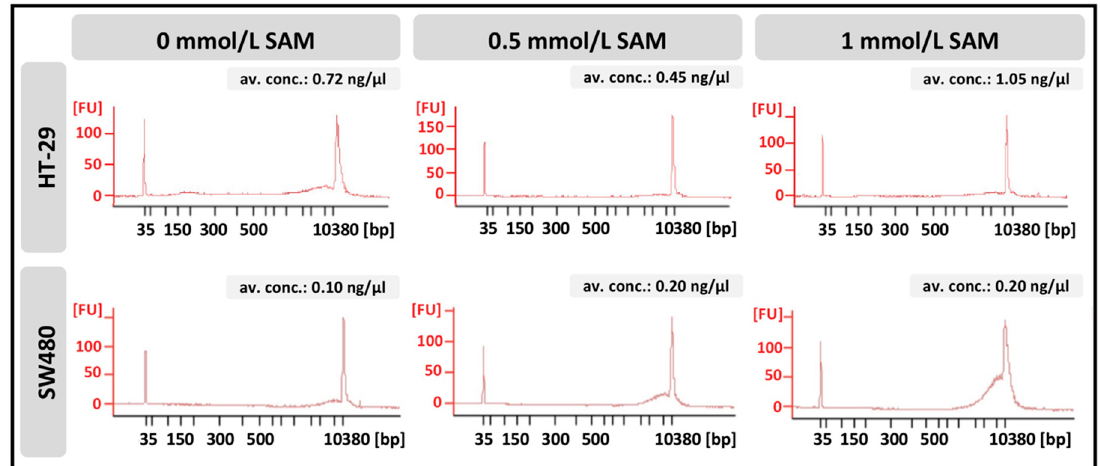
Figure 6. Fragment–length distribution of cell-free DNA isolated from the media of HT-29 and SW480 cells was detected with BioAnalyzer. Electropherograms represent a data plot of size in base pairs (bp) versus fluorescence (FU). Average DNA concentrations were measured with Qubit 1.0 fluorometer. Av. conc.: average concentration.